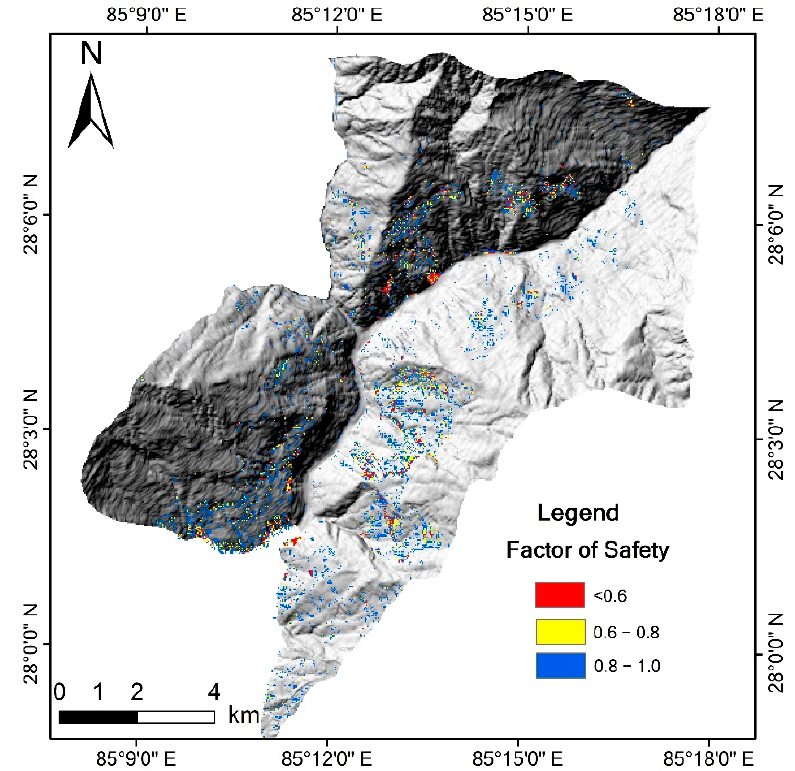
Figure 6. Unstable area under 2016 rainfall condition.